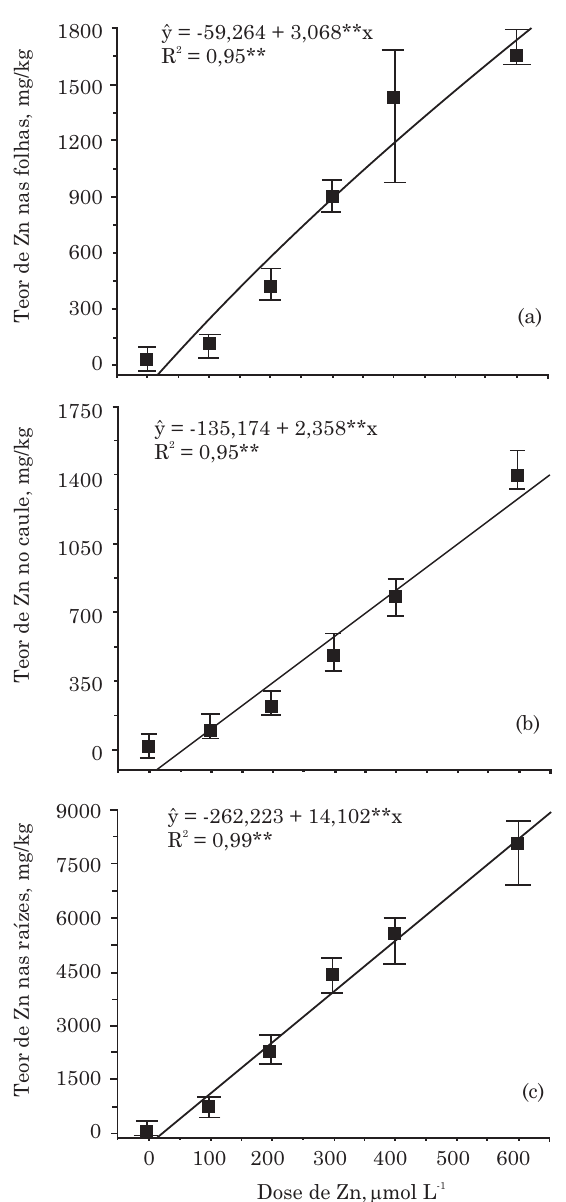
Figura 2. Teor de Zn em folhas (a), caule (b) e raízes (c) de plantas de mamona cultivadas em diferentes doses de Zn em solução nutritiva. * e **: significativo a 5 e 1 %,